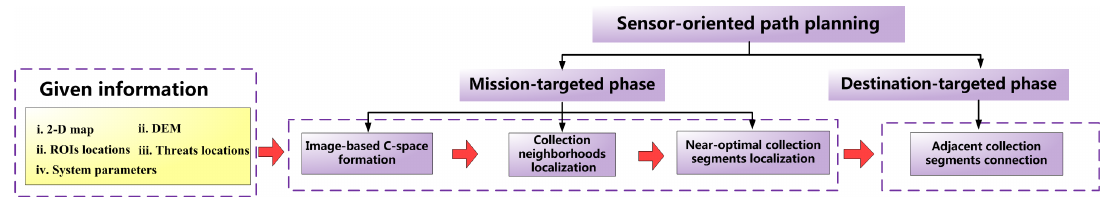
Figure 6. Framework of the proposed path planner.